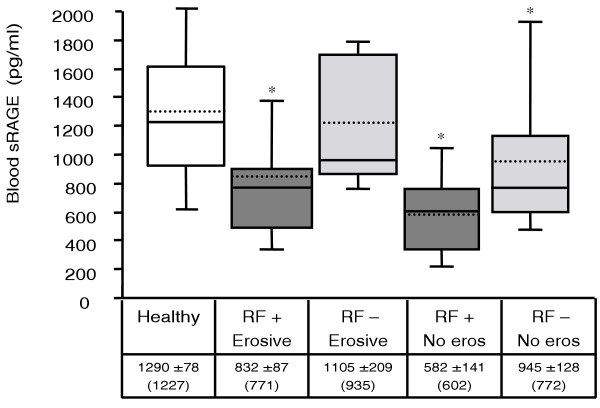
Blood soluble receptor for advanced glycation end products (sRAGE) levels of rheumatoid arthritis patients stratified with respect to seropositivity and erosivity in comparison with healthy controls. Box plots show the 25th and 75th percentiles. Horizontal lines in bold within boxes indicate medians, and dashed lines indicate means. Vertical bars indicate the 5th and 95th percentiles. Statistical differences with respect to sRAGE levels between groups were calculated using the Mann–Whitney U test. The mean ± standard deviation (median) values are shown. * P < 0.01 as compared with healthy controls. RF, rheumatoid factor; no eros, no erosion.